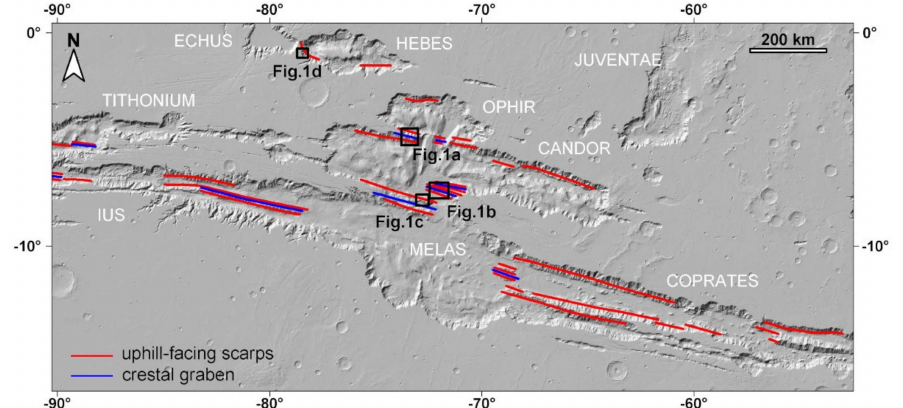
Figure 6. Locations of hypothesized major DSGSDs in Valles Marineris, with indication of the major chasmata; modified after M è ge and Bourgeois [60]. In black are the locations of the morphological elements illustrated in Figure